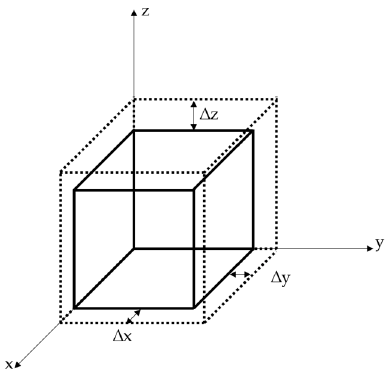
Figure 3. Sinter shrinkage behavior of metal EAM parts. The printing plane (x and y) shrinkage shows identical values, while the shrinkage in stacking direction (z) is significantly larger. The dashed lines represent the green ‐ part and the solid lines the sintered metal ‐ part.